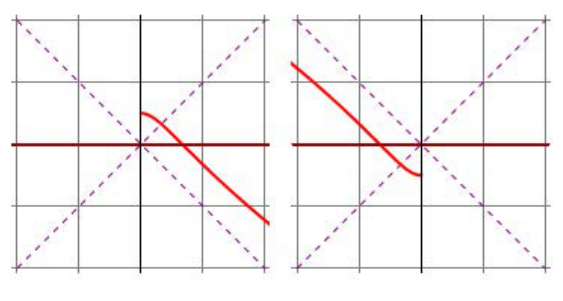
Fig. 14. Timelike curves with K( y ) = 1 − 1 / y (left) and K( y ) = − 1 − 1 / y